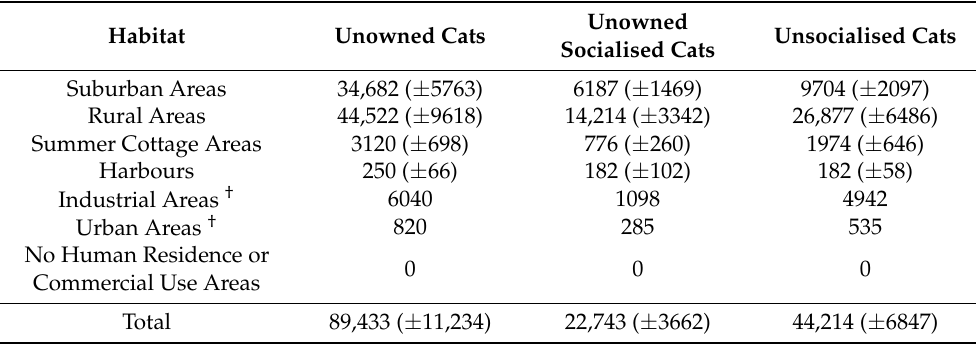
Table 5. Total populations in Denmark. Estimated population size of unowned free-ranging domestic cats from questionnaire survey data and BBKDE 95% home ranges by habitat type and in total. Standard errors are given in brackets.